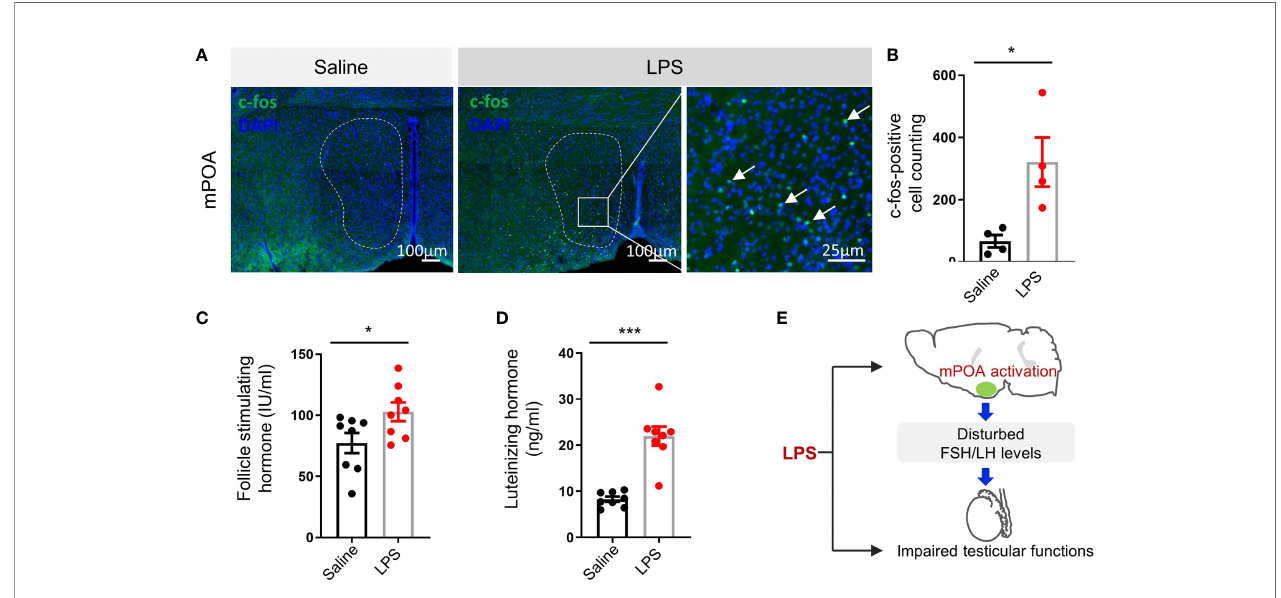
FIGURE 4 | LPS treatment resulted in the activation of medial preoptic area (mPOA) in the hypothalamus and an increase in circulating follicle-stimulating hormone (FSH) and luteinizing hormone (LH) levels. (A) Representative images of c-fos immunostaining in medial preoptic area (mPOA, green, c-fos; blue, DAPI; scale bars = 100 and 25 m m). (B) Quantitative analysis of c-fos positive neurons in the mPOA activated by LPS treatment (data are presented as mean ± SEM, n = 4 saline, n = 4 LPS; Student ’ s t-test, *p < 0.05). (C, D) The LPS-treated group had higher plasma FSH and LH levels compared with controls (data are presented as mean ± SEM, n = 8 saline, n = 8 LPS; Student ’ s t-test, ***p < 0.001, *p < 0.05). (E) A summary graph of disturbed mPOA-FSH/LH axis by LPS-induced systemic in fl